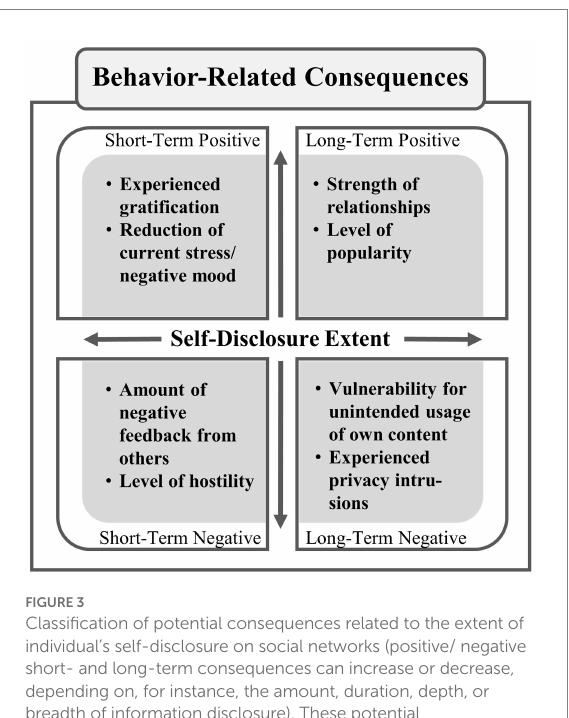
FIGURE 3 Classification of potential consequences related to the extent of individual’s self-disclosure on social networks (positive/ negative short- and long-term consequences can increase or decrease, depending on, for instance, the amount, duration, depth, or breadth of information disclosure). These potential consequences are exemplary and do not claim to be